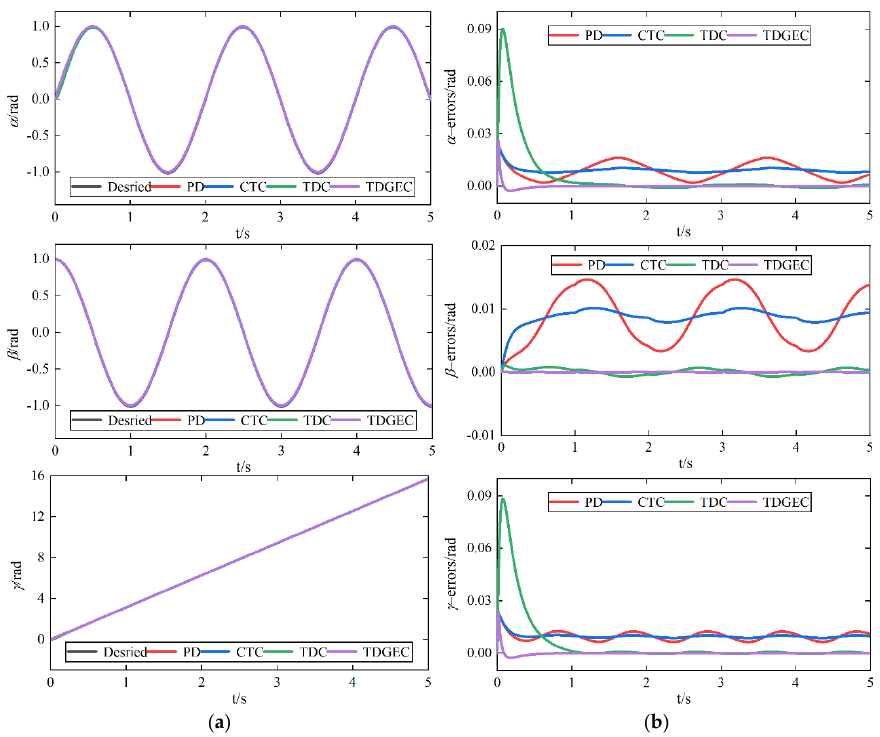
Figure 8. Simulation results: ( a ) Tracking curves ( w = 3) and ( b ) Tracking error curves ( w = 3).